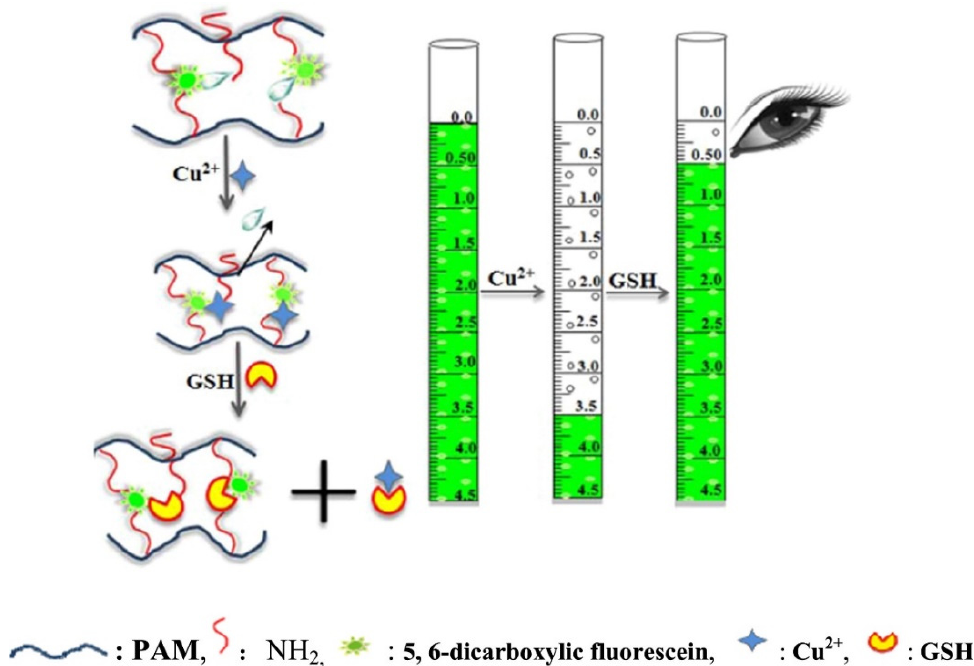
Figure 2. Hydrogel for volumetric response to glutathione (GSH). Reprinted from Reference [50] with permission from Elsevier. License Number: 5156040364062.